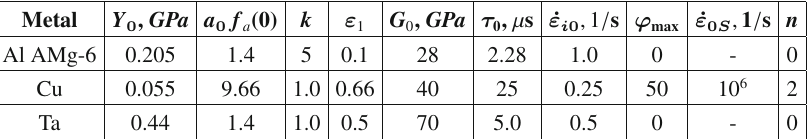
Table 2. Constant coe ffi cients of equations